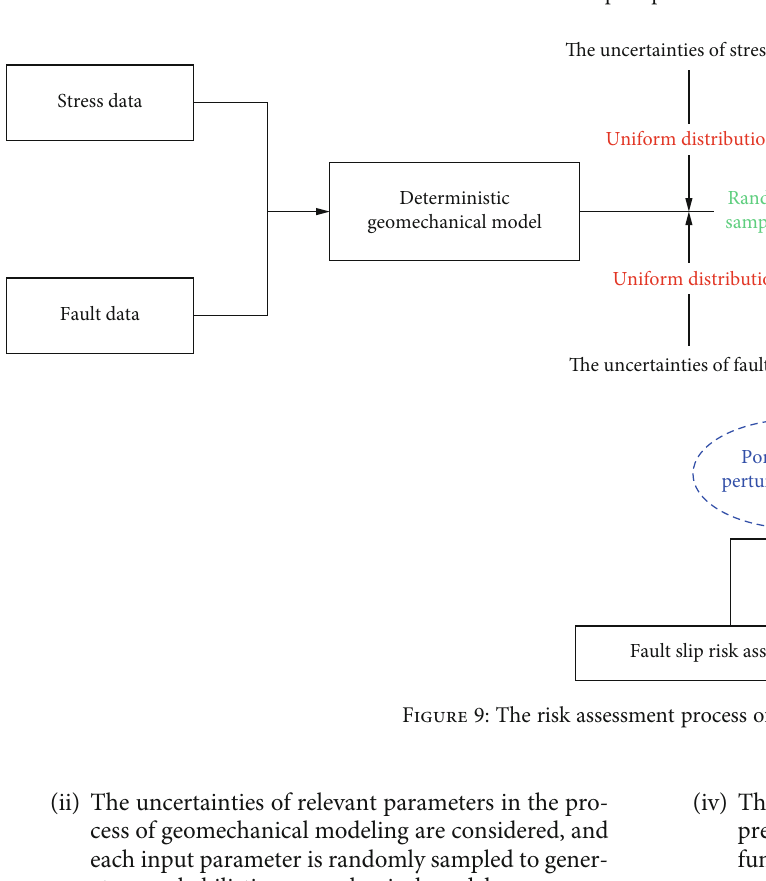
Figure 8: The distribution of pore pressure in the Ning209 block.